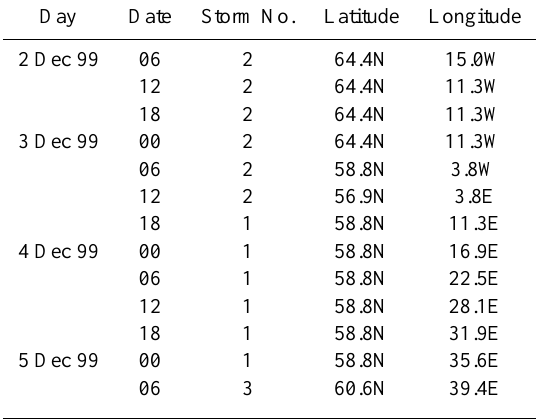
Table 2. Track of the storm “Anatol” from Iceland across the Ger- man Bight into the area of the Baltic States, between 2 and 5 De- cember 1999. Level: